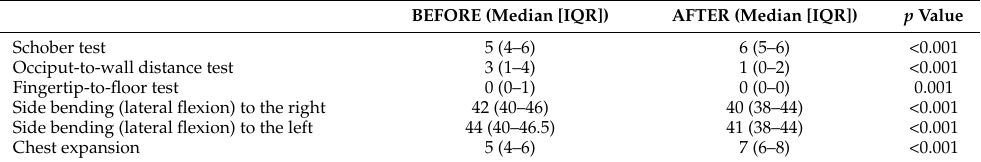
Table 9. Differences between the before and after values related to the four motion programmes based on Wilcoxon signed-rank